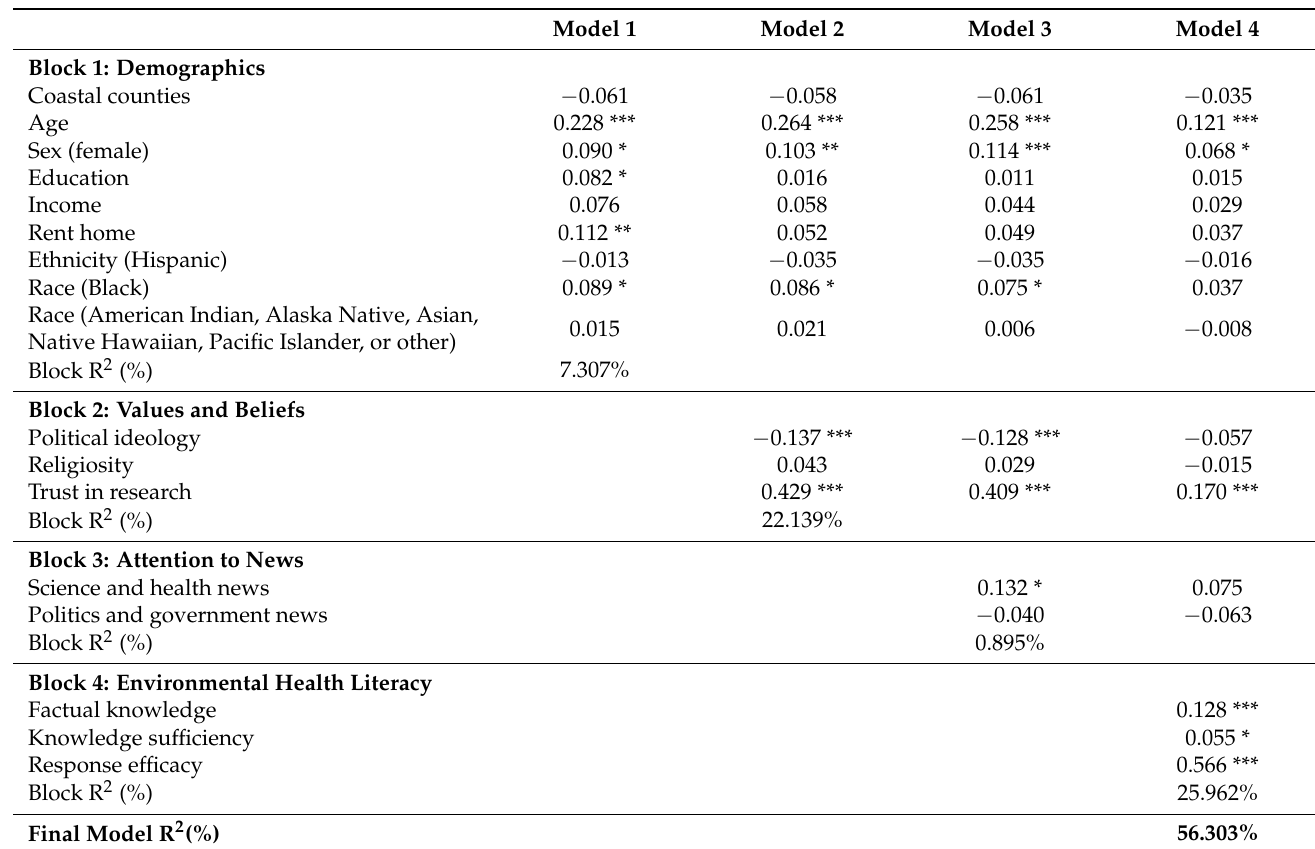
Table 1. Results of stepwise multiple regression predicting willingness to engage in protective behaviors against COVID-19 based on demographics, values/beliefs, news use, and environmental health literacy. N = 716 1 . Model 1 Model 2 Model